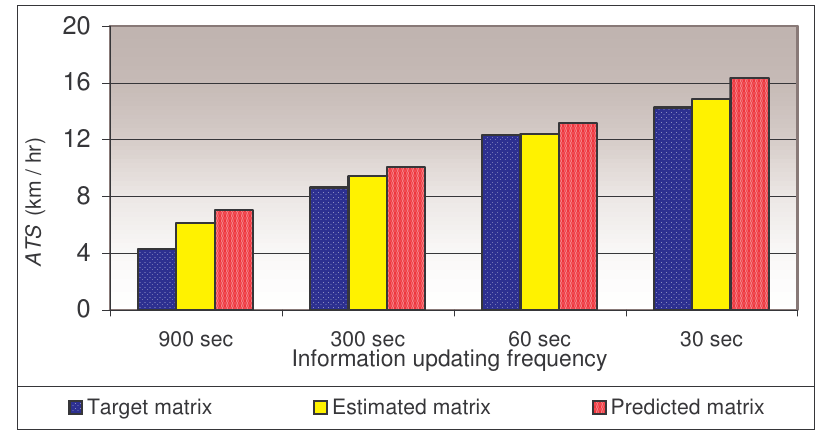
Figure 5. Changes in the ATS (km/hr) for different information updating frequencies and loading